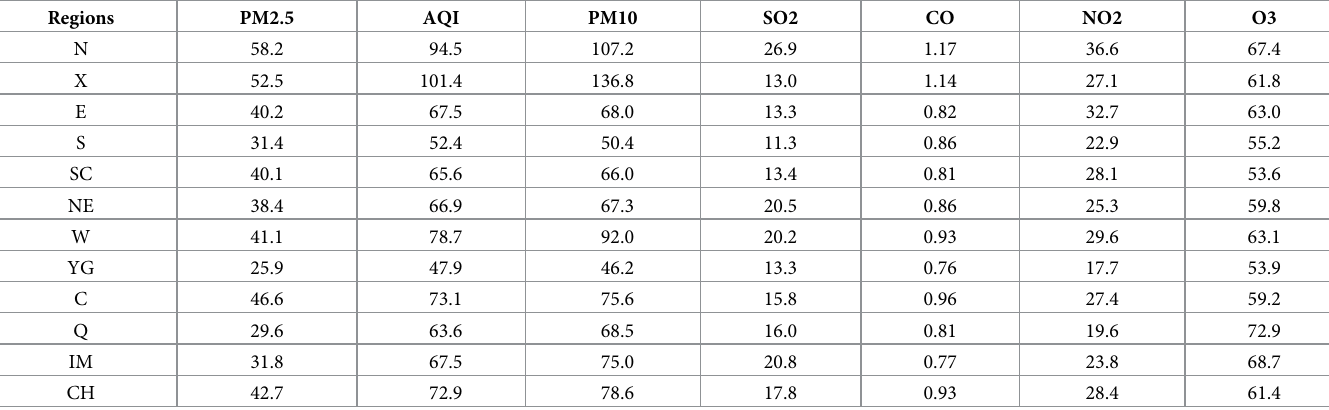
Table 1. Annual mean concentration of pollutants from 2015 to 2019.